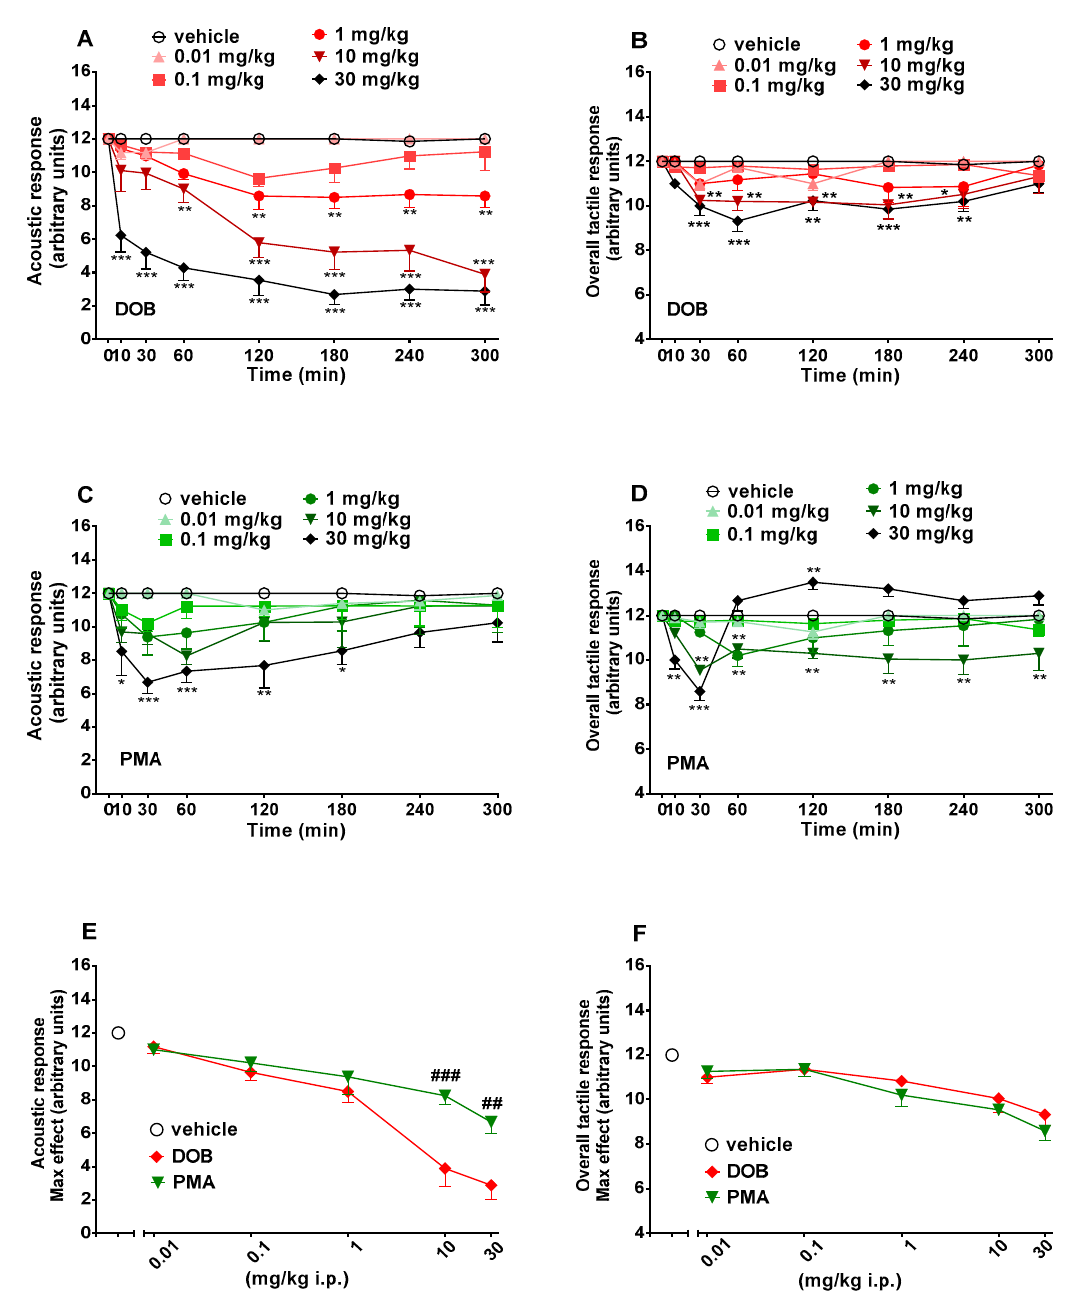
Figure 3. E ff ect of DOB (0.01–30 mg / kg i.p.; panels A and B ) and PMA (0.01–30 mg / kg i.p.; panels C and D ) on the acoustic ( left ) and the overall tactile ( right ) response in the mice and comparison of the maximum e ff ect observed in 5 h on visual object (panel E ) and visual placing (panel F ) tests. Data are expressed as mean ± SEM ( n = 8 / group). Statistical analysis was performed by two-way ANOVA followed by Dunnett’s test for multiple comparisons for the dose–response curve of each compound at di ff erent time points (panels A – D ) and for the statistical analysis of the maximum e ff ect observed in 5 h (panels E and F ). * p < 0.05, ** p < 0.01, *** p < 0.001 versus vehicle; ## p < 0.01, ### p < 0.001 versus DOB.